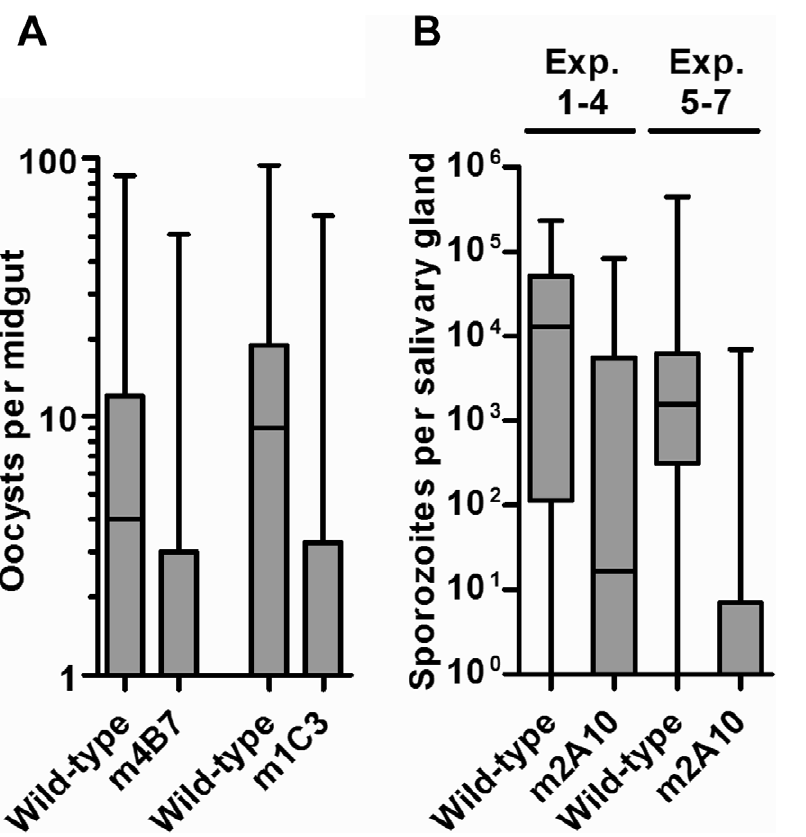
Figure 5. P.falciparum oocyst or sporozoite burden in transgenic and wild-type control mosquitoes. Box plots display the observed distribution of oocyst per midgut or sporozoite per salivary gland pair values for wild-type control mosquitoes and m1C3 P4.1, m4B7 25.1, or m2A10 44.1 transgenic mosquitoes. The boxes in each panel represent from bottom to top the 25 th to 75 th percentiles, while the vertical lines and small horizontal bars delimit the minimum and maximum values. Horizontal bars within the boxes indicate the median value of each group. (A) Plots of data from all challenge experiments with m4B7 25.1 and m1C3 P4.1 mosquitoes. (B) The plot represents data from m2A10 44.1 experiments 1–4 and 5–7 separately, as